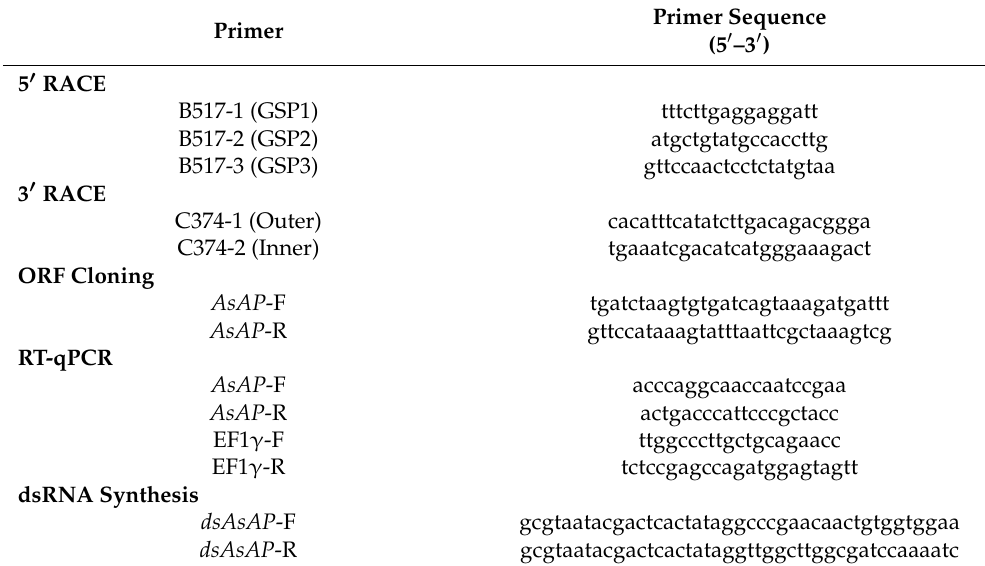
Table 1. The primers that were used for cDNA cloning, RT-qPCR and dsRNA synthesis. Primer